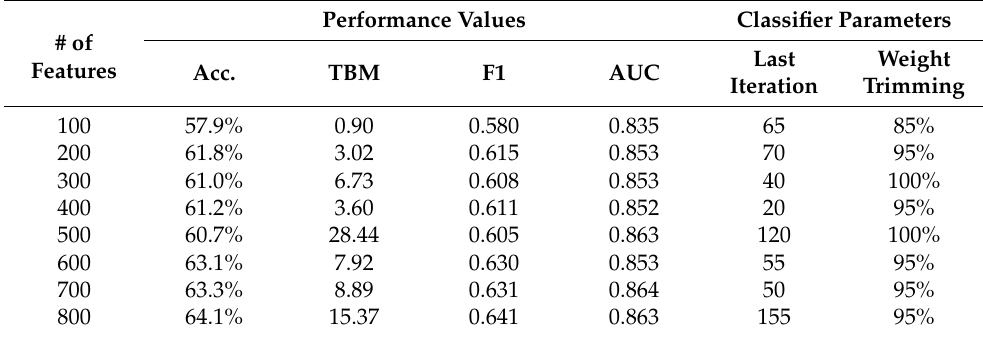
Table 6. The best performance of SL over different feature sets.